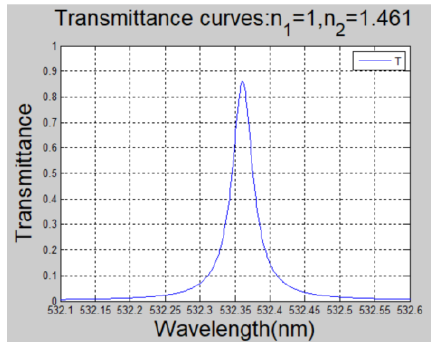
T represents the theoretical pass rate curve,